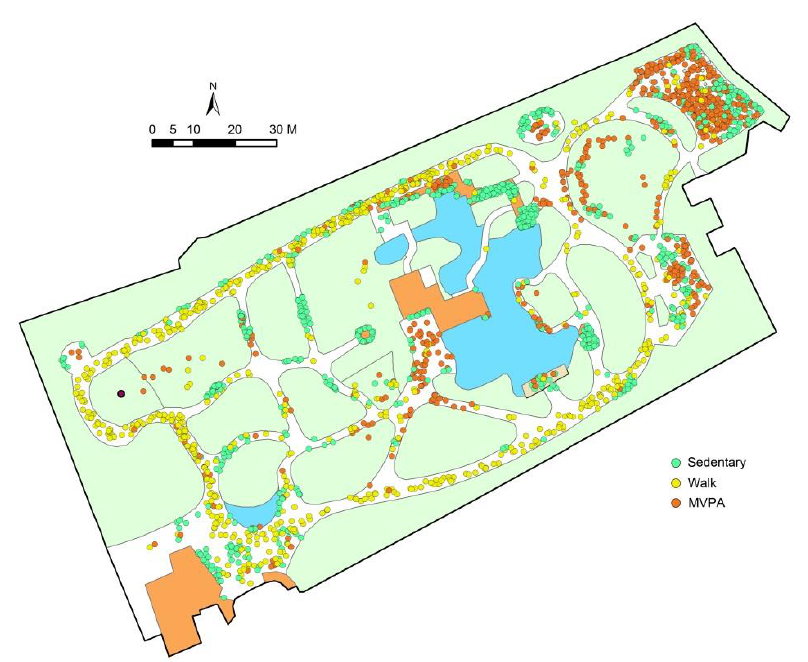
Figure A1. Behavior map of Songhe Park showing the distribution of users (the data were from nine rounds of observations: morning, noon and afternoon, three times each).